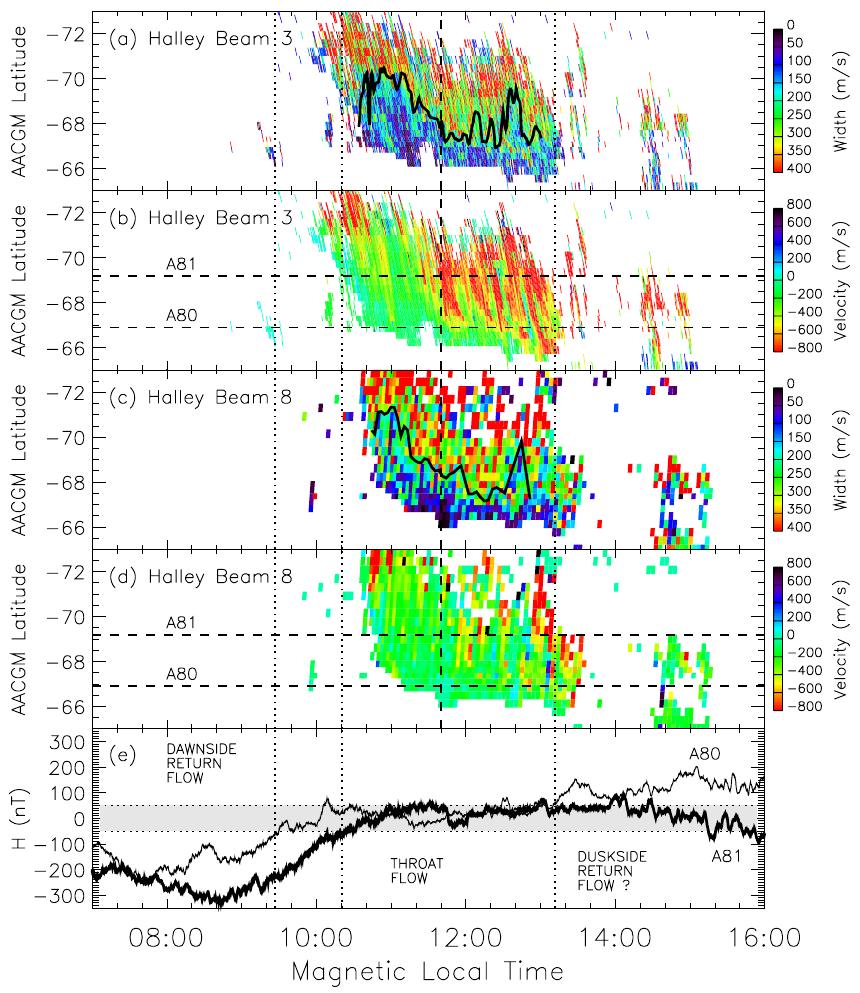
Fig. 6. ( a ) The spectral width varia- tion seen by Halley beam 3. The bold line represents an estimate of the spec- tral width boundary from the spectral width observations. ( b ) The Doppler line-of-sight velocity variation seen by Halley beam 3. The vertical dashed line represents the transition between the two flow regimes seen by beam 3. The horizontal dashed lines denote the latitudes of the A80 and A81 magne- tometers. ( c ) The spectral width vari- ation seen by Halley beam 8. The bold line represents an estimate of the spec- tral width boundary from the spectral width observations. ( d ) The Doppler line-of-sight velocity variation seen by Halley beam 8. ( e ) H -component mag- netometer data from the A80 and A81 (bold line) AGO magnetometers in the Antarctic. The vertical dotted lines de- lineate estimates of the boundaries be- tween the throat and return flow as esti- mated from the magnetometer